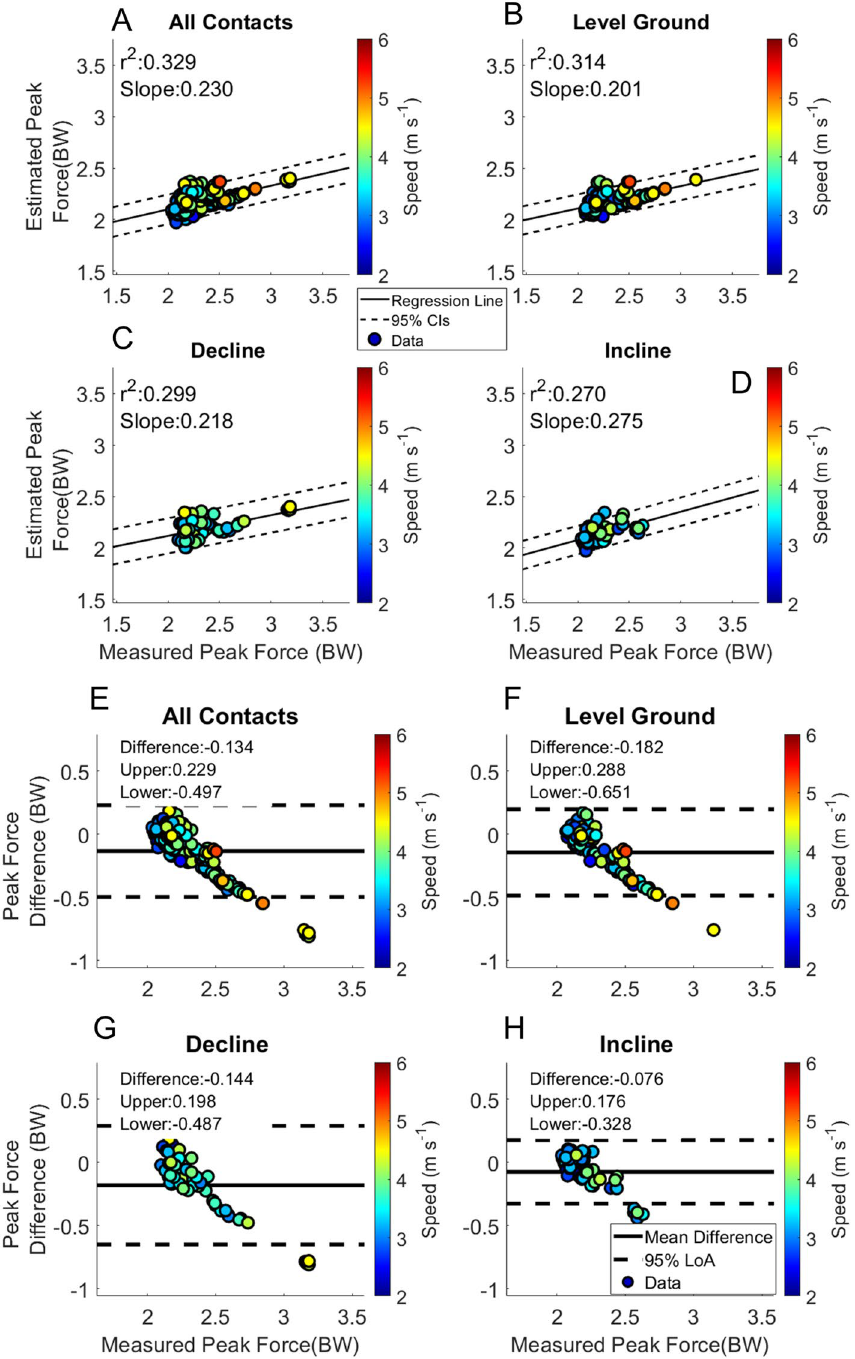
Figure 7. Peak Force. Linear regression and Bland–Altman plots are presented for all foot contacts ( A and E ), followed by level ground ( B and F ), decline ( C and G ) and incline foot contacts ( D and H ). Pearson Correlation Coefficients and the slope of the regression line are presented in panels ( A – D ). The Bland–Altman plots present differences between the estimated and measured stance average GRF. The average difference and the 95% LoA are shown in panels ( E – H